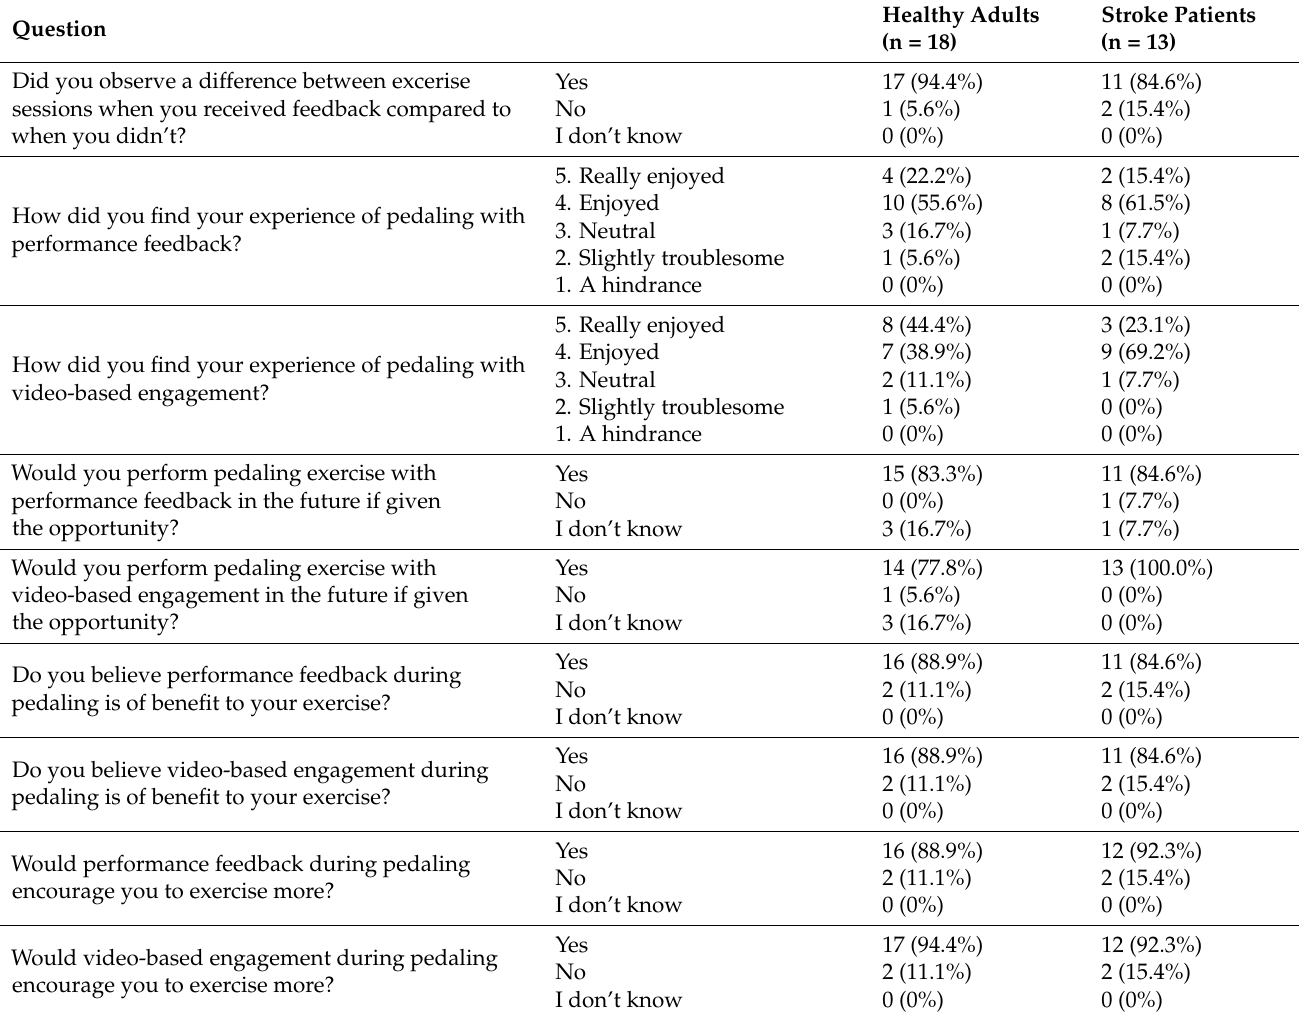
Table 2. Self-reported outcome survey, including results for both stroke patients and healthy young adult